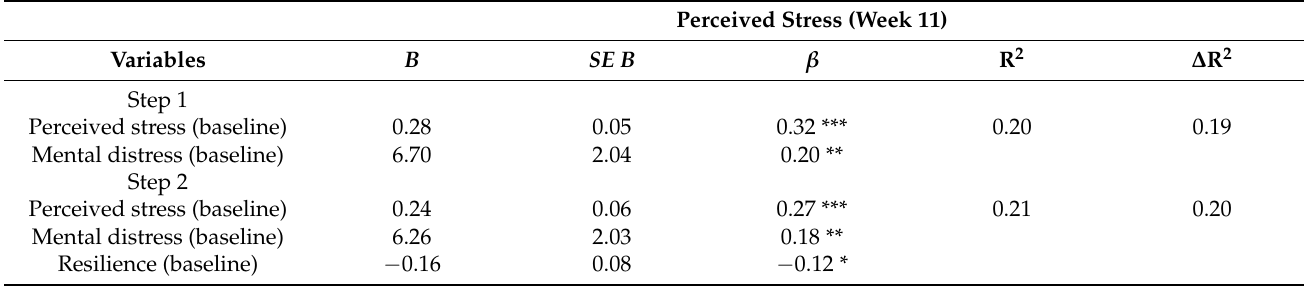
Table 2. The influence of resilience (baseline) on perceived stress (week 11) in a hierarchical regression analysis, controlling for baseline values of perceived stress (baseline) and mental distress